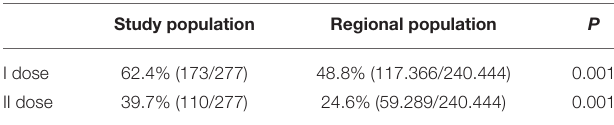
TABLE 1 | Differences in vaccine coverages between study cohort and regional population.